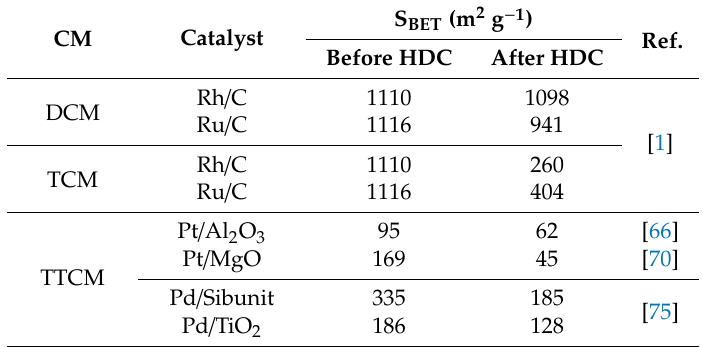
Table 3. Specific surface area of the catalysts before and after used in the HDC